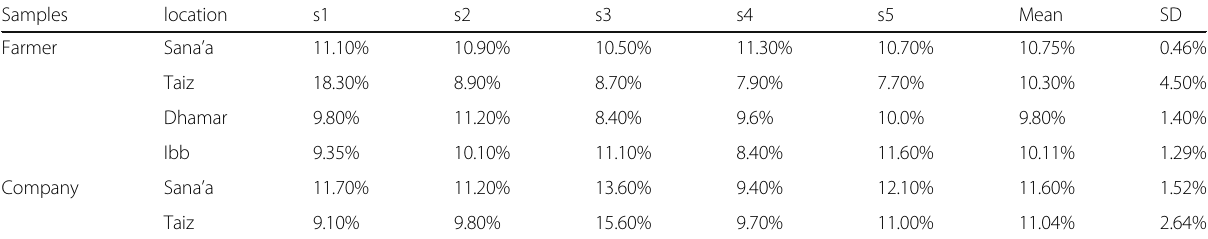
Table 1 Mean of moisture contents % (M.C.) in poultry ration samples collected from four governorates Samples